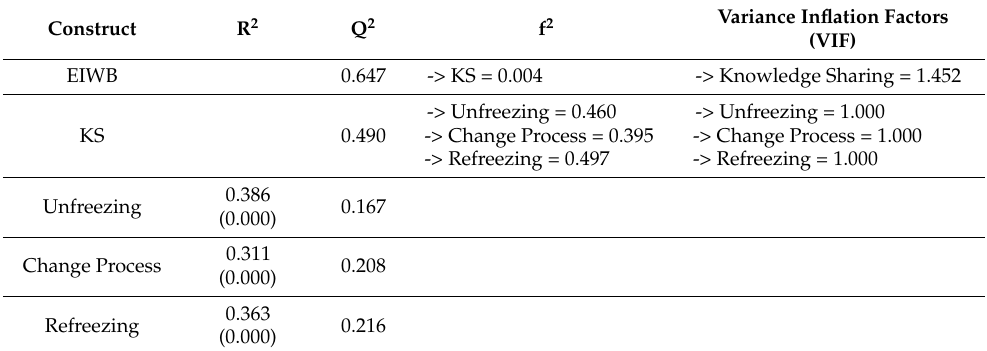
Table 4. R 2 , Q 2 , f 2 , and VIF